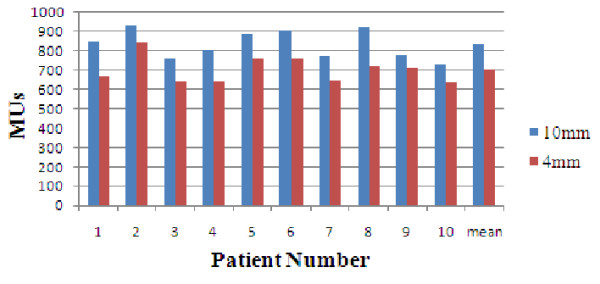
Case-by-case comparison of the delivering MUs between the IMRT plans with the mMLC and the sMLC (10 and 4 mm: MLC leaf widths of 10 and 4 mm, respectively).